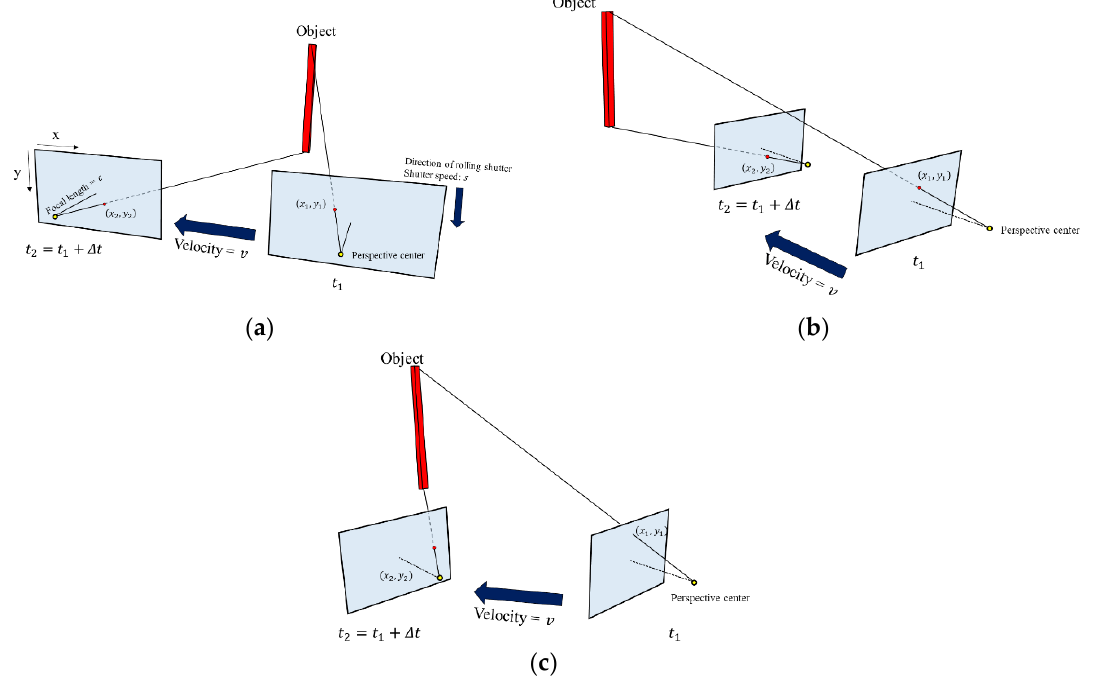
Figure 3. Camera moving scenario: ( a ) parallel to the image plane; ( b ) perpendicular to the image plane; and (c) at a certain angle to the image plane .